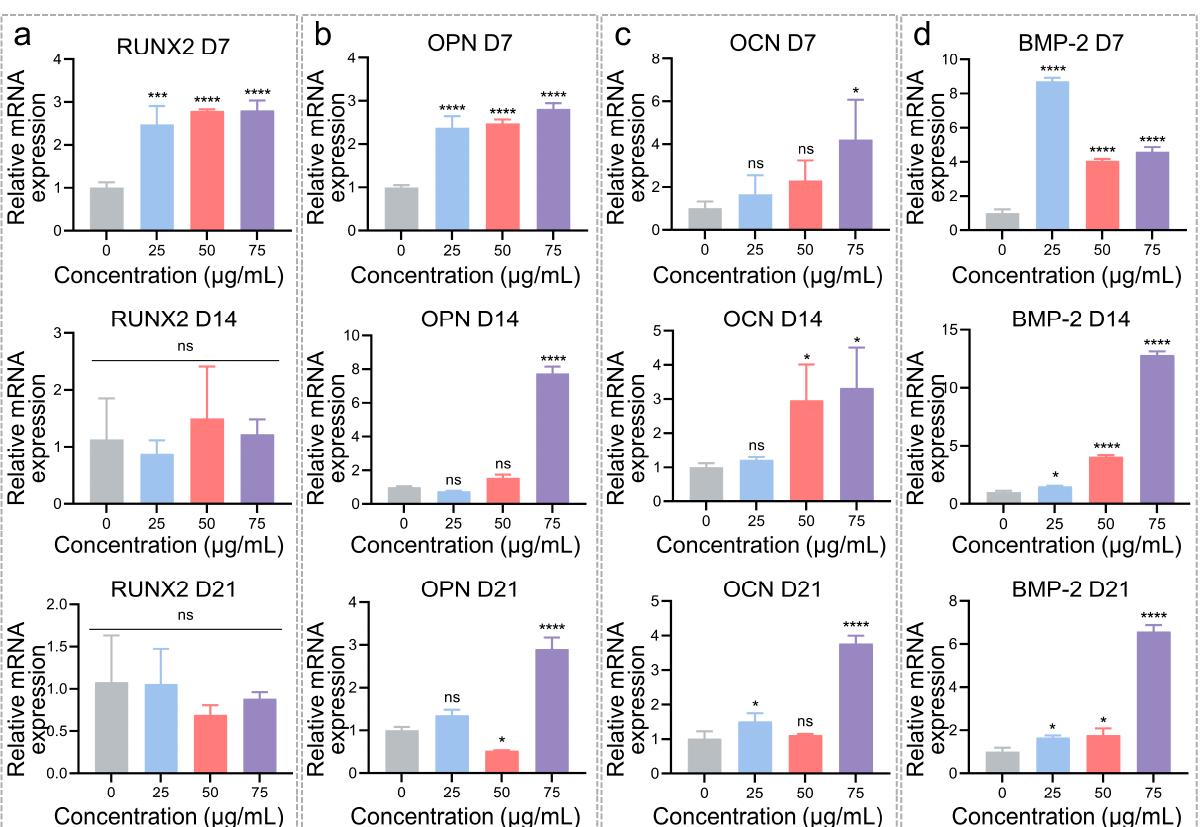
Figure 4. Osteogenic-specific gene expression by real-time quantitative polymerase chain reaction (RT–qPCR) analysis. RUNX2 ( a ), OPN ( b ), OCN ( c ) and BMP-2 ( d ) mRNA expression on Day 7, Day 14, and Day 21. Data represent mean ± standard deviation ( n = 3). Significance was determined by one-way ANOVA (* p < 0.05, *** p < 0.001, **** p < 0.0001, ns: not significant vs. the 0 μ g/mL group).